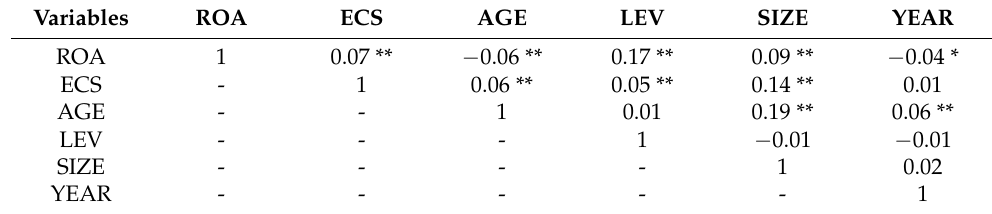
Table 4. Correlation matrix for the entire sample.